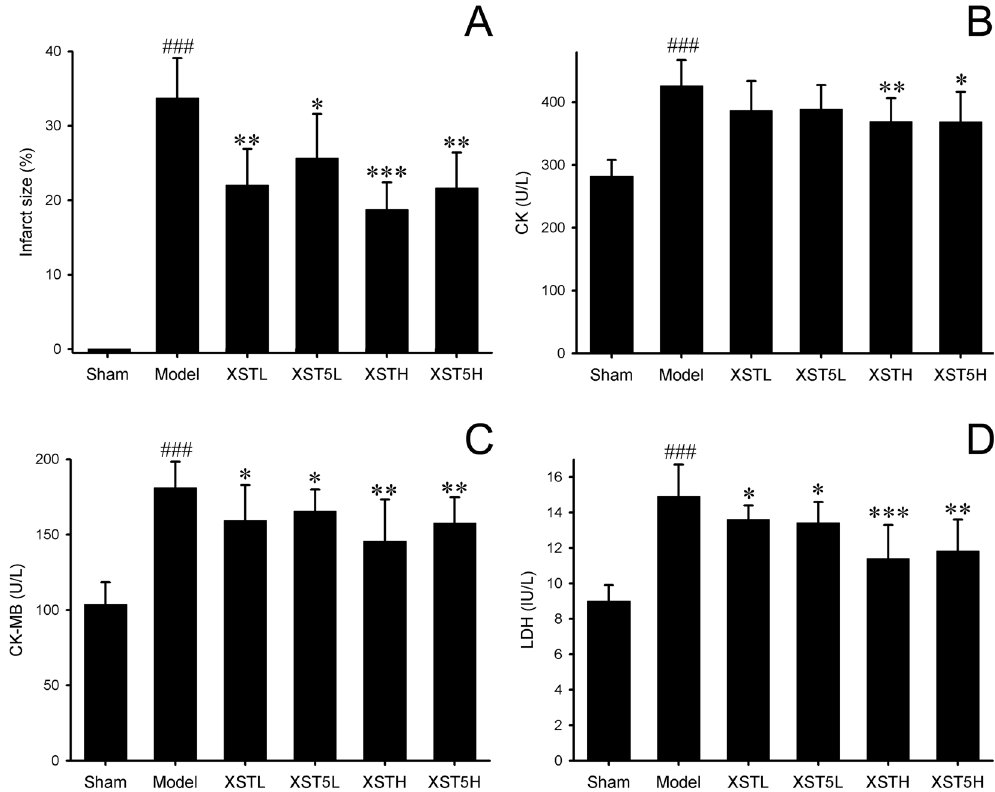
Figure 4. The effect of XST and XST5 in myocardial infarction. ( A ) The effect on infarct size (n = 6). The effect on CK ( B ), CK-MB ( C ) and LDH ( D ) activity (n = 10). All values are means ± SD. ### p < 0.001 vs. Sham group, * p < 0.05 vs. Model group, ** p < 0.01 vs. Model group, *** p < 0.001 vs. Model group.